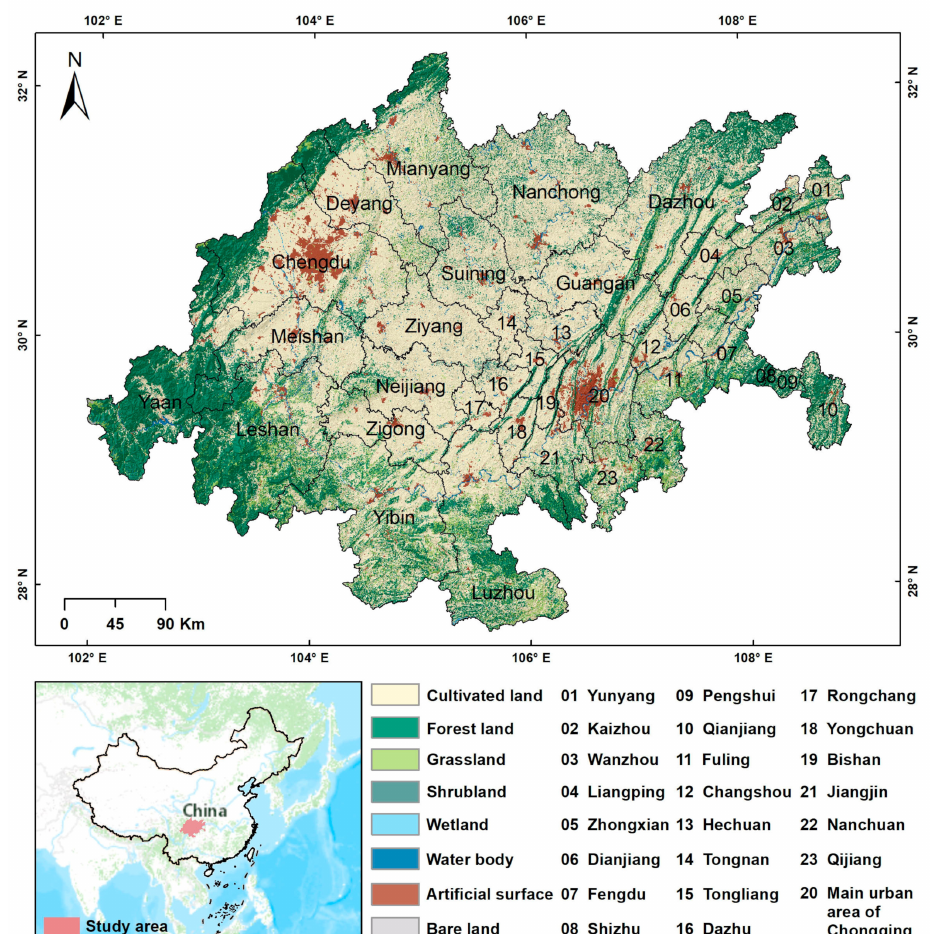
Figure 1. Location of the study area and spatial distribution of land use